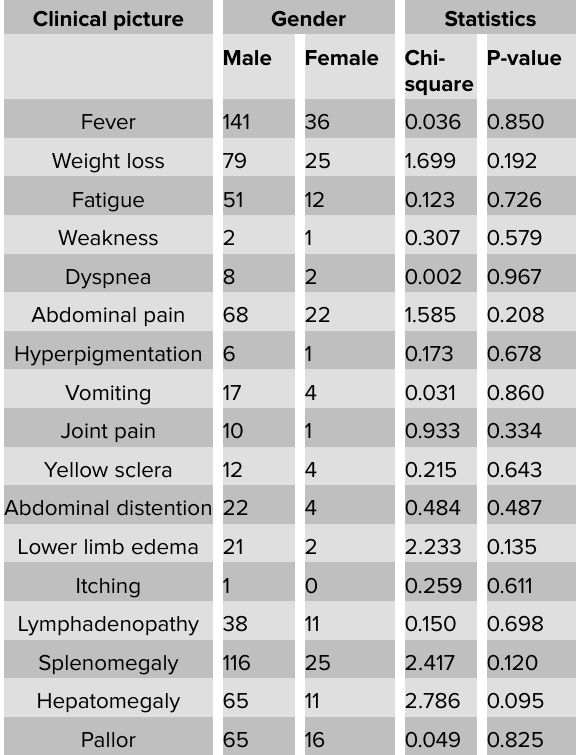
Table 8: Association between clinical presentations of patients diagnosed with VL at the TDTH and their